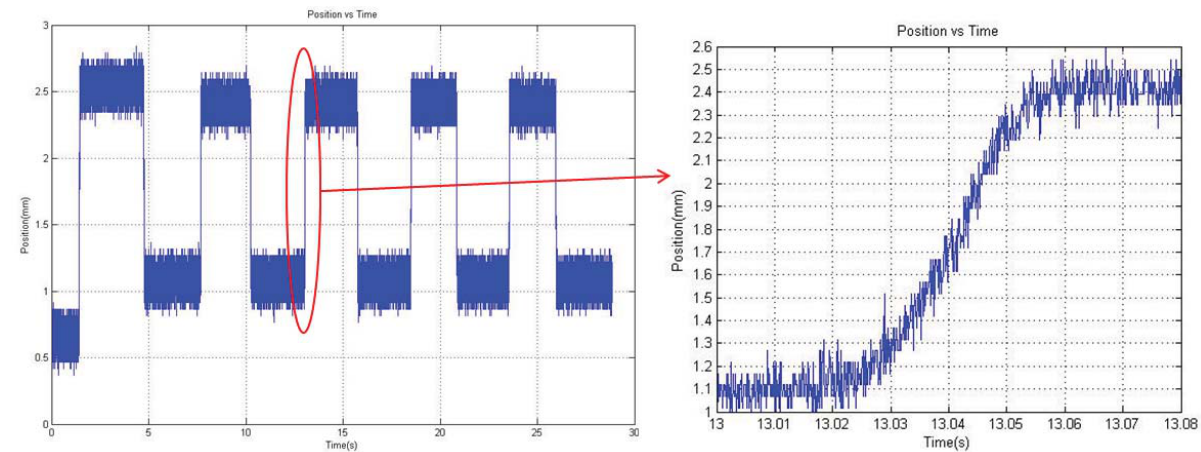
Figure 7. Preliminary test in order to determine K